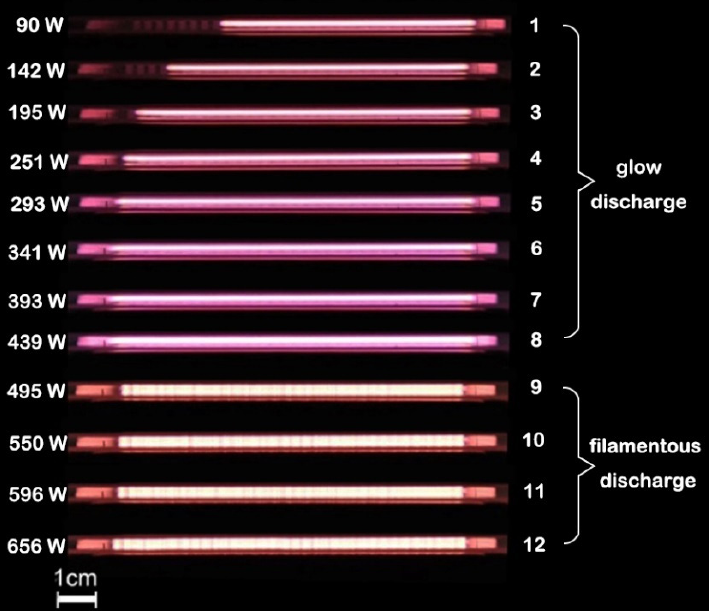
Figure 3. Photos of 2.2 mm RF-DBD using argon-doped nitrogen, N 2 = 50 mL/min, gas mixture = 2 L/min. Photos 1–12 correspond to points 1–12 in Figure 2. Exposure time: 1 ms.